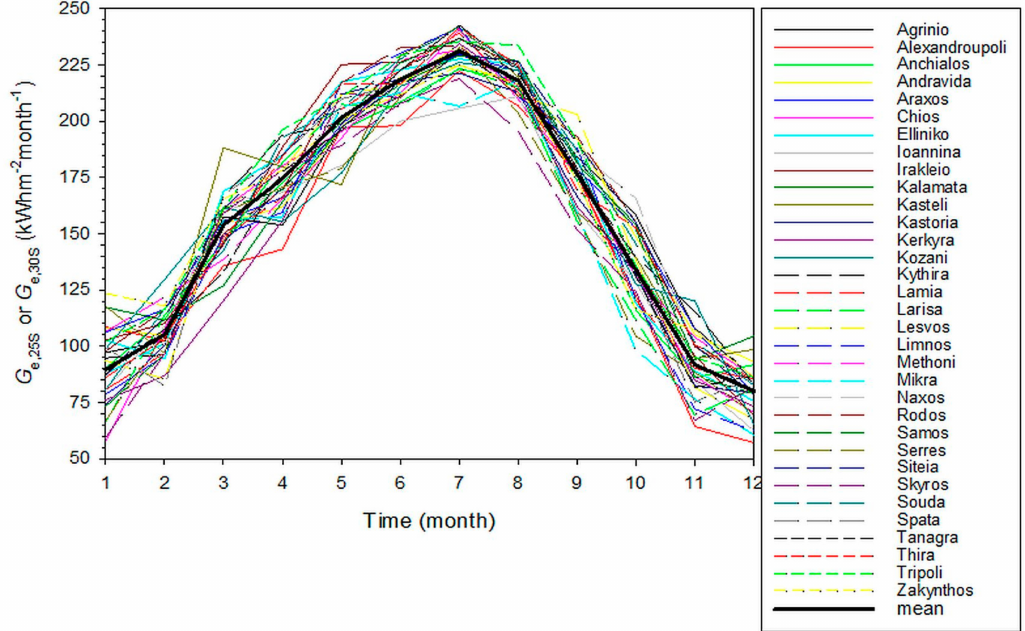
Figure 6. Intra-annual variation of G e, β S ( β = 25 ◦ or β = 30 ◦ ) at all sites belonging to the four PV ctts zones. The black bold curve represents the intra-annual variation of G e, β S averaged over all sites.